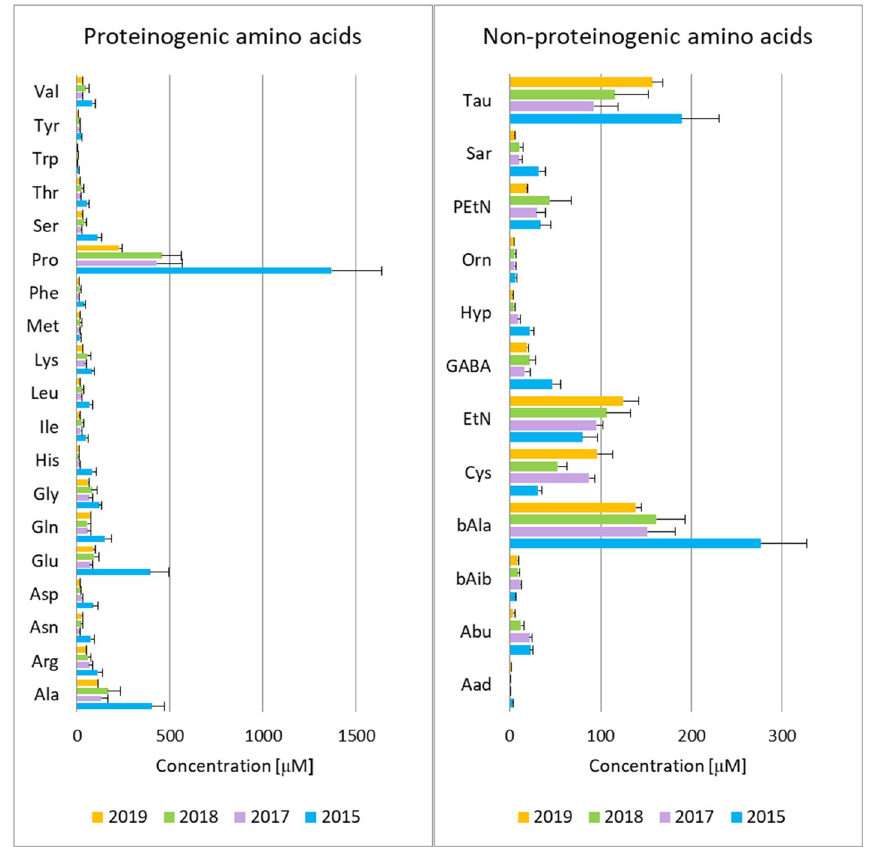
Figure 2. Free amino acid profiles determined in honeybee venom samples. Amino acid profiles (average and SEM) determined in solutions (c = 50 mg/ml) of honeybee venom samples collected in different years. Amino acid abbreviations are defined in Supplementary Table